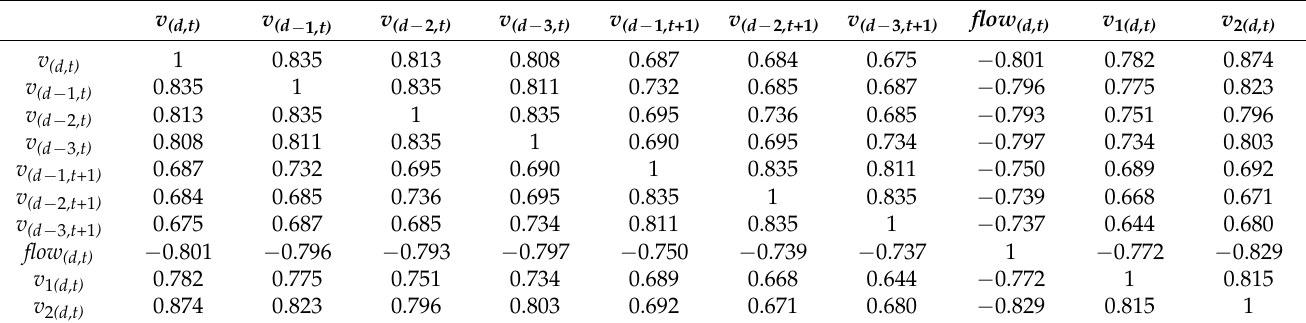
Table 2. Pearson correlation coefficients for northbound traffic on Xingzhong Rd.